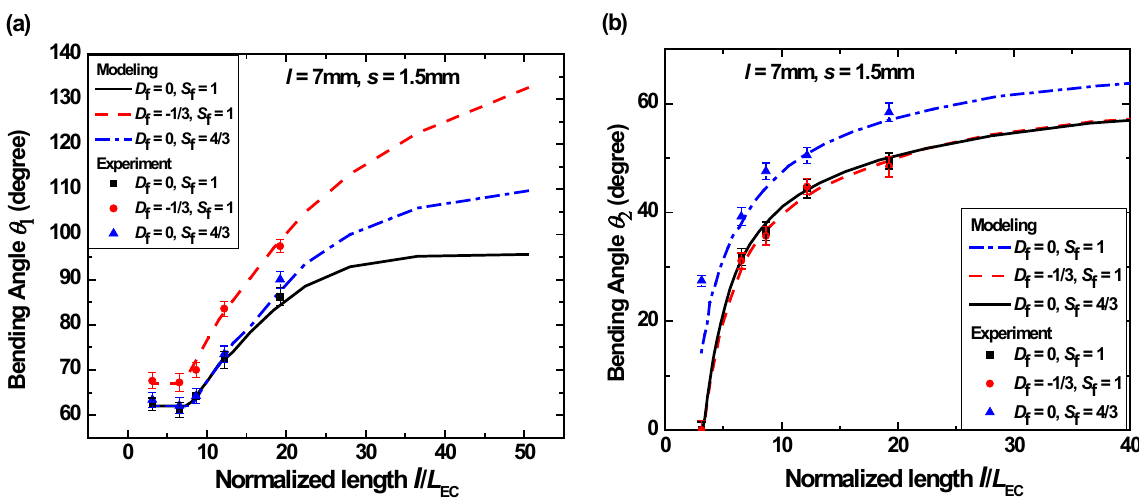
Figure 13. Modeling and experimental results of the bending angles ( a ) θ the membranes in contact with a surface incorporating a sulcus as a function of the normalized